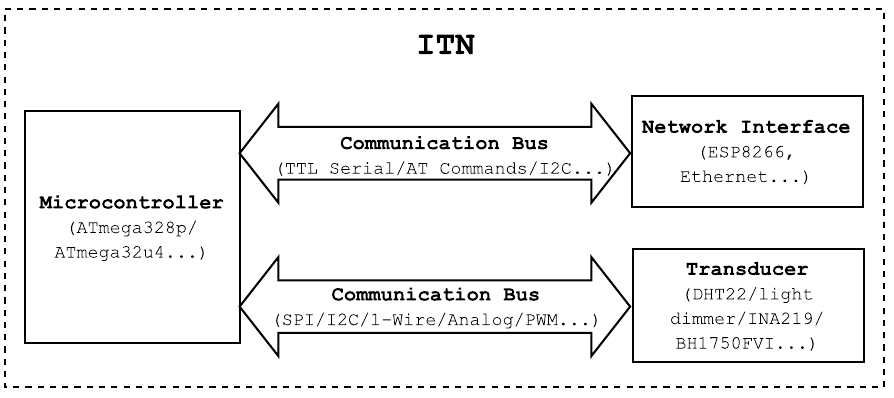
Figure 3. Generic ITN components and communication